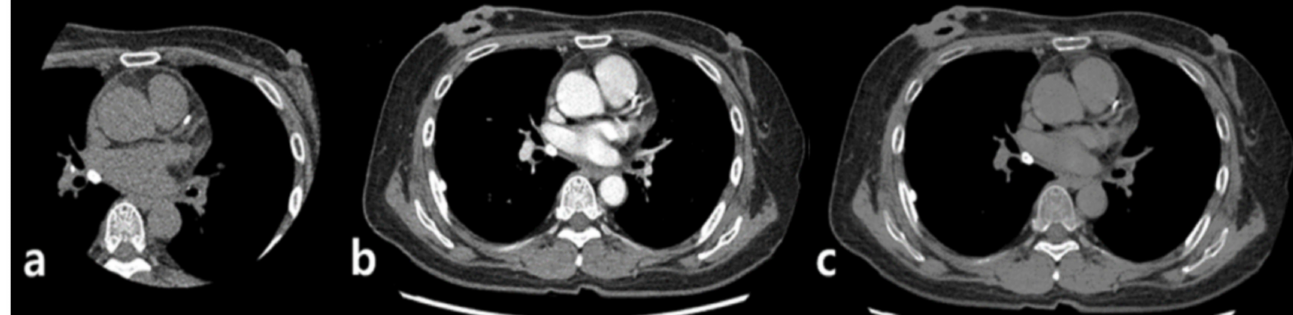
Figure 2. Process of image acquisition. First, ECG-gated non-enhanced calcium-scoring CT was performed ( a ). Subsequently, non-ECG-gated contrast-enhanced dual energy chest CT was performed with reconstructed virtual 70keV monochromatic images, which are similar to 120-kVp images ( b ). Finally, virtual unenhanced images were acquired with the material-suppressed iodine technique ( c ).